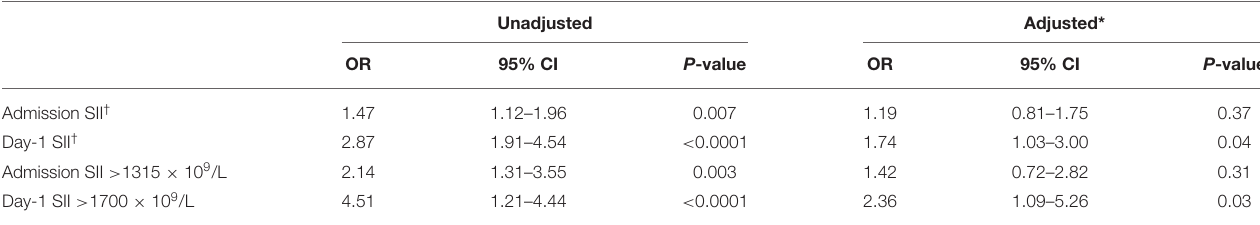
TABLE 2 | Relationship of SII and SII threshold with 90-day predicting poor outcome.